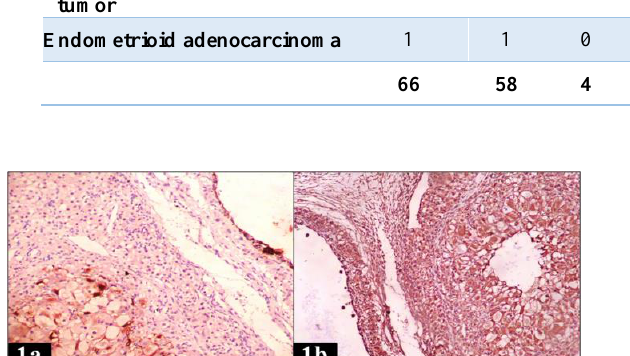
Granulosa cells showed moderate coexpression of All ovarian epithelial tumors were positive for cytokeratin expression. Serous tumors of ovary exhibited vimentin expression depending on the degree of differentiation. Vimentin expression was absent in 24/28 (85.71%) of cases withbenign serous tumors. All borderline and malignant serous tumors were positive for vimentin with different degrees of positivity. The 3+ grade for vimentin was present in 5/8 (62.5%) and 2+ grade in 2/8 (28.57%) of cases withserous adenocarcinoma. No borderline serous tumor showed grade 3+ expression for vimentin, 3/5 (60%) of cases were 2+ grade and 2/5(40%) were 1+ grade. The relationship between CK and vimentin expression were statistically significant (figures 2, 3, and